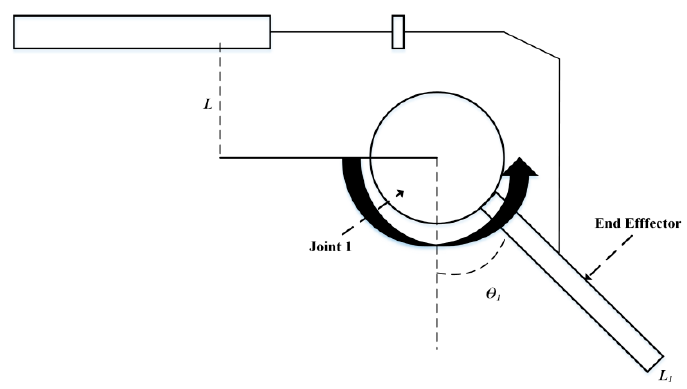
Figure 2. Third link schematic diagram. Table 1. Hydraulic link parameters.